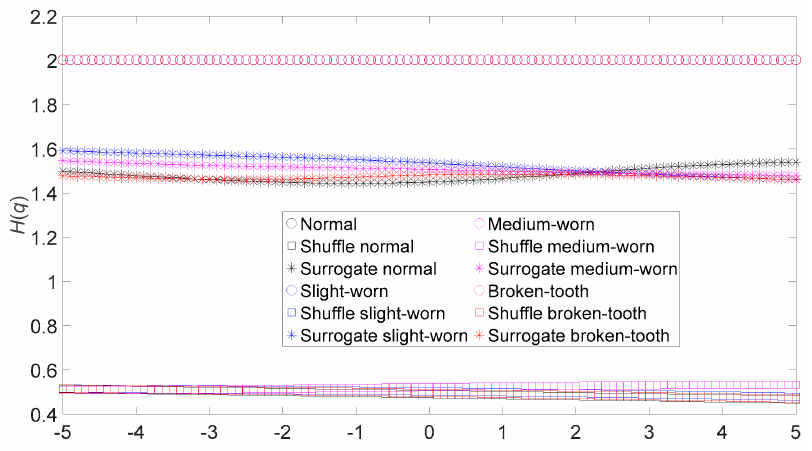
Figure 24. Generalized Hurst exponents of the original, shuffle, and surrogate versions of the four types of gear vibration data.